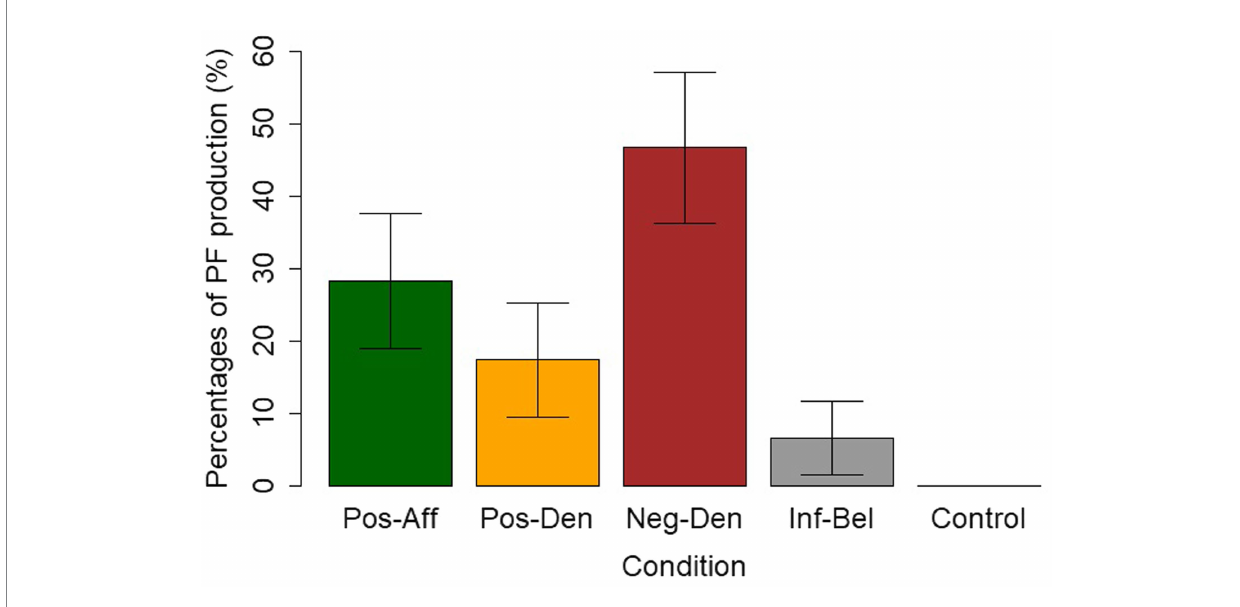
FIGURE 2 Percentages of PF productions by condition ( N = 92).